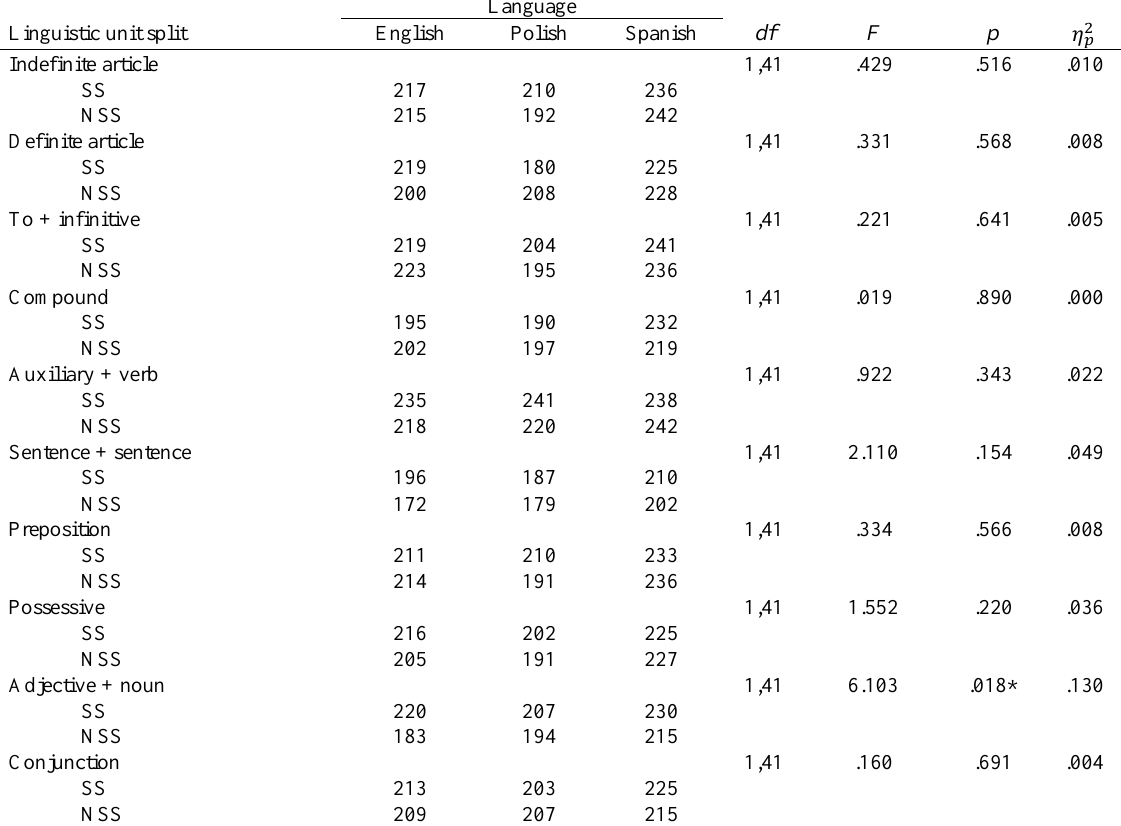
Table 5. Mean fixation duration by linguistic unit and